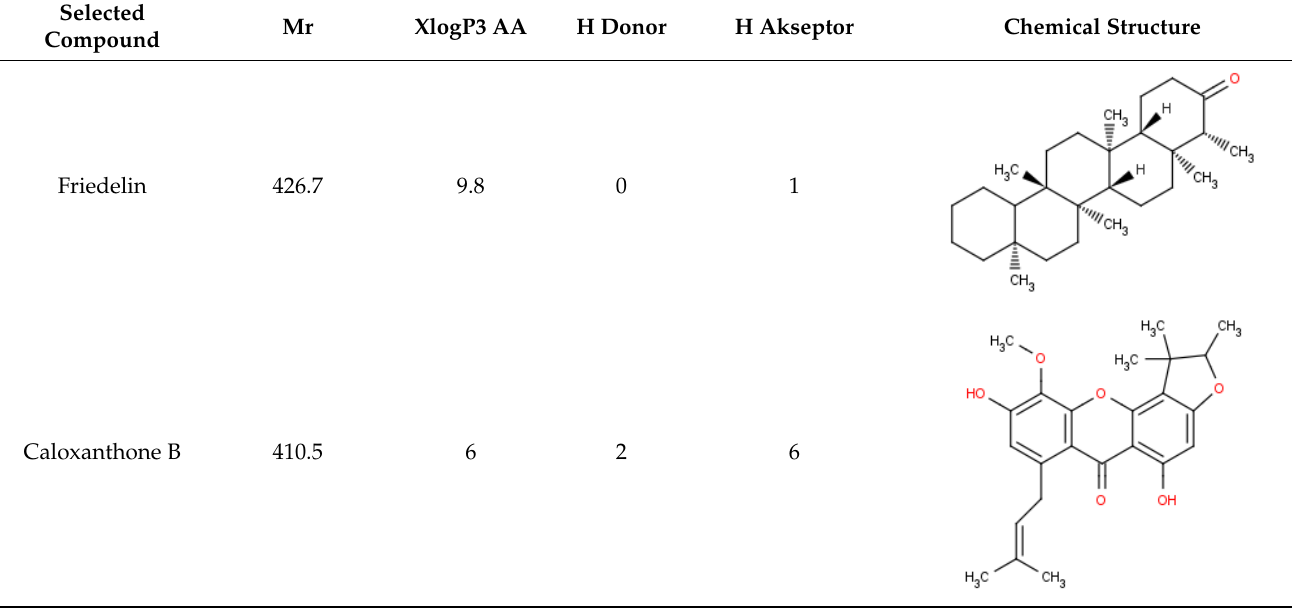
Table 4. Drug-likeness prediction of the compounds in Calophyllum soulattri . Selected